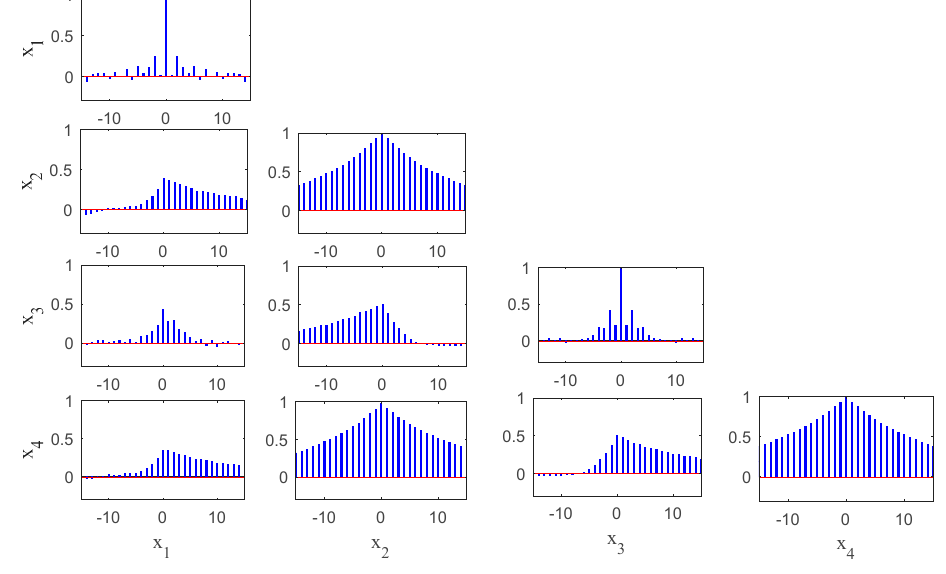
Figure 4. Correlation plots for the first four process variables. Figure 4 shows the correlation and cross-correlation between the first four process variables. The value at time 0 in each figure represents the cross-correlation between variables; the value at non-zero time shows the autocorrelation between variables under different time lags. It is worth mentioning that the cross-correlation index can measure the redundancy of variable information, and the autocorrelation index can indirectly measure the dynamic and time delay information between variables. It can be seen that the cross-correlation performance between the variables was above 0.5, indicating that there was strong redundant information between the variables. At the same time, even if there was a difference of 10 sampling times, the autocorrelation between the variables was still very high, indicating that there were time lags and dynamic characteristics between the variables. Therefore, the establishment of a DALM model for the process can be considered. The emission equation of the model extracts the redundant information of the data, and the autoregressive equation of the model extracts the dynamic and time lag information of the variables. This paper uses the trend similarity algorithm, which constructs the trend similarity function according to the time lag feature and solves it, to determine the time lag coefficient, that is, L =